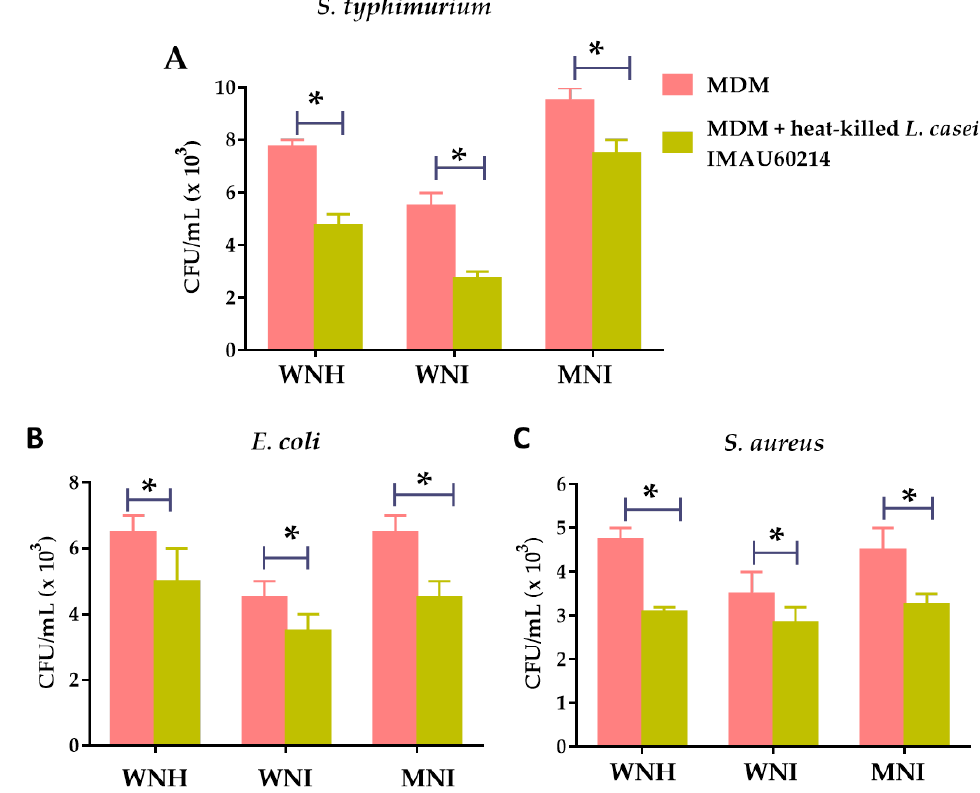
Figure 4. Effect of heat-killed L. casei IMAU60214 on the bactericidal activity of MDM cells from WNH, WNI and MNI children. MDM cells were pretreated or untreated with heat-killed L. casei IMAU60214 (500:1, Bacteria: MDM) for 24 h and then challenged with ( A ) S . typhimiurium , ( B ) E. coli and ( C ) S. aureus for 120 min; after that, they were washed and incubated with gentamicin to eliminate extracellular bacteria. Data are shown as CFU / mL recovered after MDM lysis. Each bar shows mean of triplicates ± SD of two independent experiments ( n = 15). Asterisk indicates significant differences (* p < 0.05) between each condition analyzed with the treatments (Student’s t paired test).